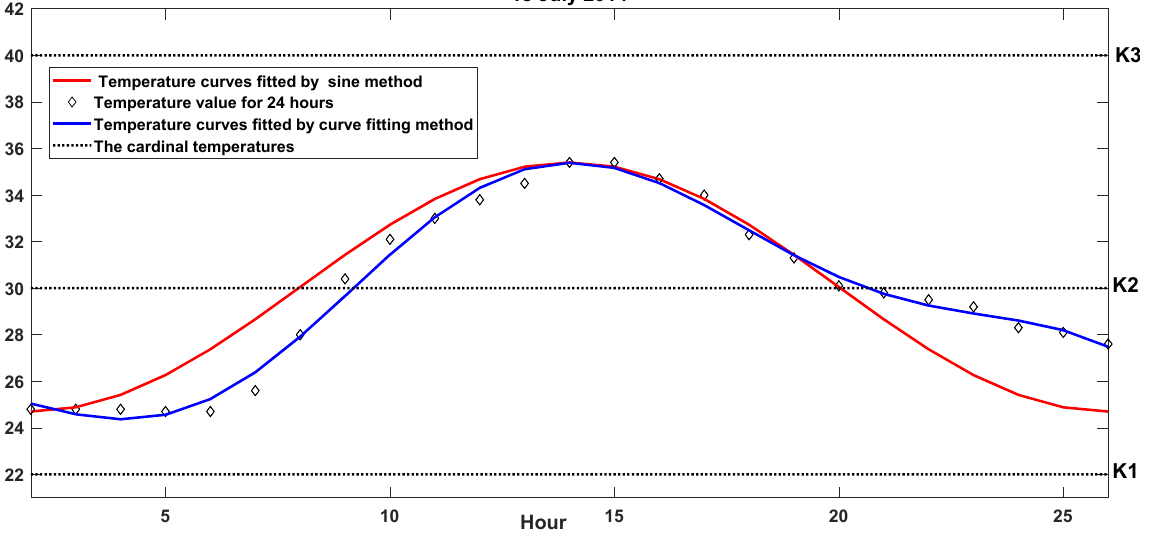
Figure 8. Comparison of temperature curves fitted by the CAGDD ‐ SM method and the CFAGDD ‐ SM method.